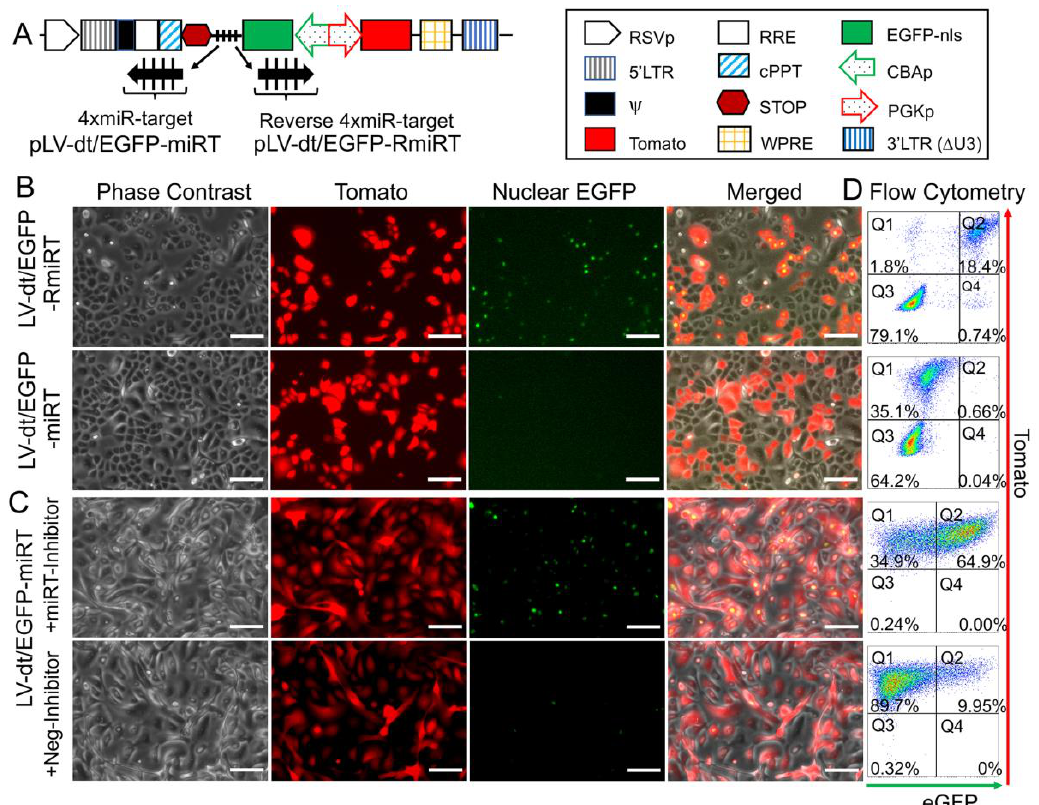
Figure 3. Incorporation of miR-106b target sequence (miRT) into the 3′-UTR of EGFP effectively detargets lentiviral-mediated expression in proliferating basal cells. ( A ) Diagram of the bidirectional promoter proviral lentiviral plasmids (pLV-dt/EGFP-miRT and pLV-dt/EGFP-RmiRT) used to generate lentivirus and test detargeting in basal cells. The box legend to the right highlights the components of these proviral plasmids as described in detail within the Figure 2A legend. LV-dt/EGFP-miRT is the experimental vector harboring a CBA promoter driven nuclear targeted EGFP (EGFP-nls) with miR-106b target sequence (4× miR target or mirT) in the reverse orientation. In the forward direction, the PGK promoter drives expression of the Tomato reporter, which is unaffected by miR-106b. LV-dt/EGFP-RmiRT is a control vector with the miRNA target sequence in the reverse orientation. ( B ) LV-dt/EGFP-miRT and LV-dt/EGFP-RmiRT viruses were used to transduce primary human airway basal cell in SAGM-EA cultures. The Tomato-positive (red) cells indicate the virally transduced cells. EGFP expression is seen in dt/EGFP-RmiRT control transduced cells but not in cells transduced with the detargeted LV-dt/EGFP-miRT vector. Scale bar, 100 µm. ( C ) Basal cells transduced with LV-dt/EGFP-miRT vector, and FACS isolated for Tomato-positive cells, were transfected with miRT-106b inhibitor sequences to block detargeting or mock transfected. Scale bar, 100 µm. ( D ) The cells in (B and C) were analyzed by flow cytometer and are shown in dot plots to the right of the corresponding images for each condition. The percentage of cells are indicated in each quadrant: Q1 (Tomato-positive only cells), Q2 (Tomato and EGFP double-positive cells), Q3 (EGFP-positive only cells), and Q4 (non-fluorescent cells).